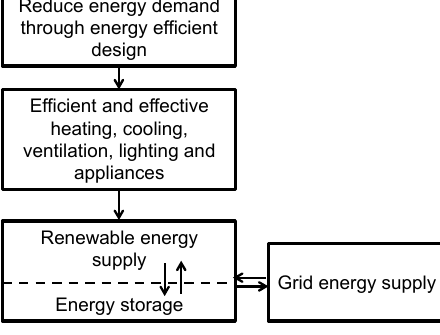
Figure 16. A systems approach to energy-positive design.